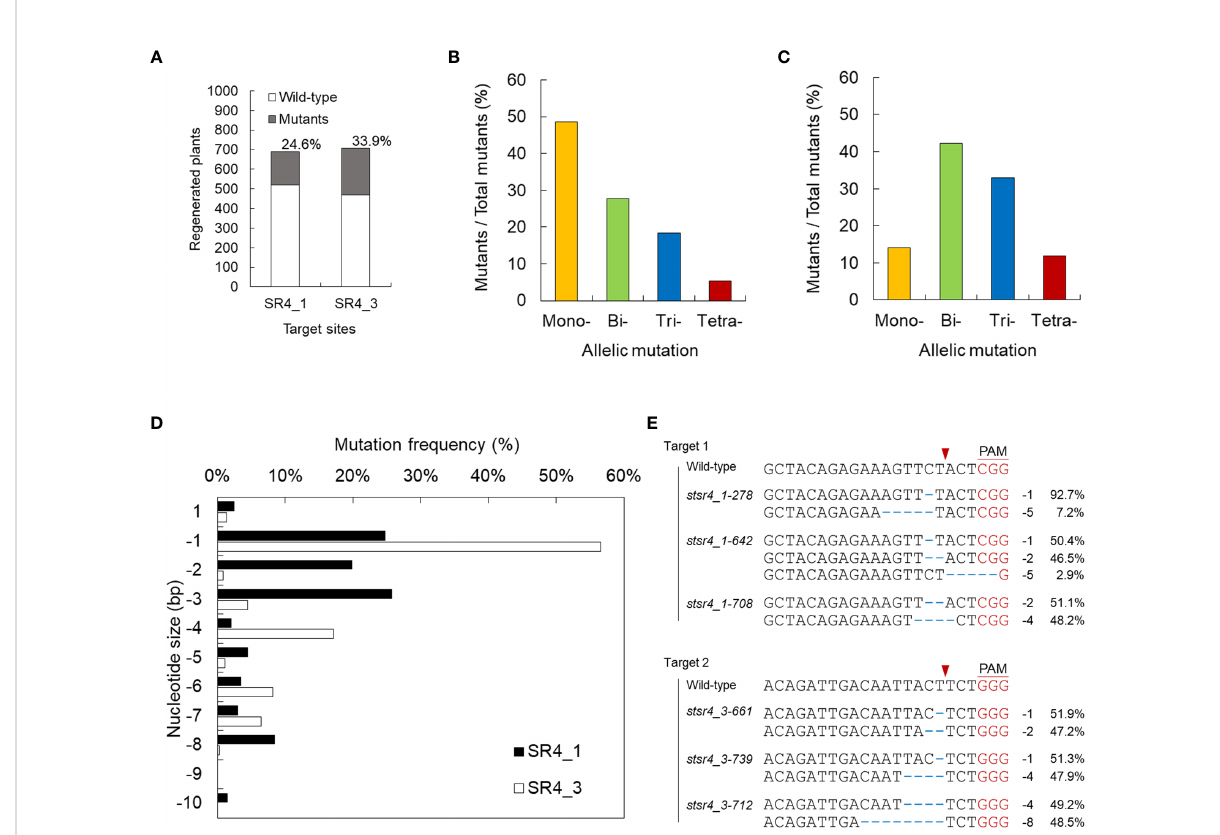
FIGURE 2 Screening for mutants induced by StSR4 gene editing of regenerated plants. (A) Ef fi ciency of stsr4 knockout mutant regeneration from protoplasts transfected with SR4_1 and SR4_3 RNPs. A total of 170 and 240 mutants were identi fi ed by PCR, followed by Sanger sequencing, among 691 and 708 SR4_1 and SR4_3 transfected protoplast-derived regenerated potato plants, respectively. (B, C) Mutation type of mutants induced by the RNPs of SR4_1 (B) and SR4_3 (C) . Mono-, only one allele is mutated; Bi-, the two alleles are mutated; Tri-, the three alleles are mutated; Tetra-, the four alleles are fully mutated. (D) Targeted deep sequencing-based analysis of indel patterns in the regenerated mutants. (E) Sequence analysis by targeted deep sequencing of 4 KO stsr4